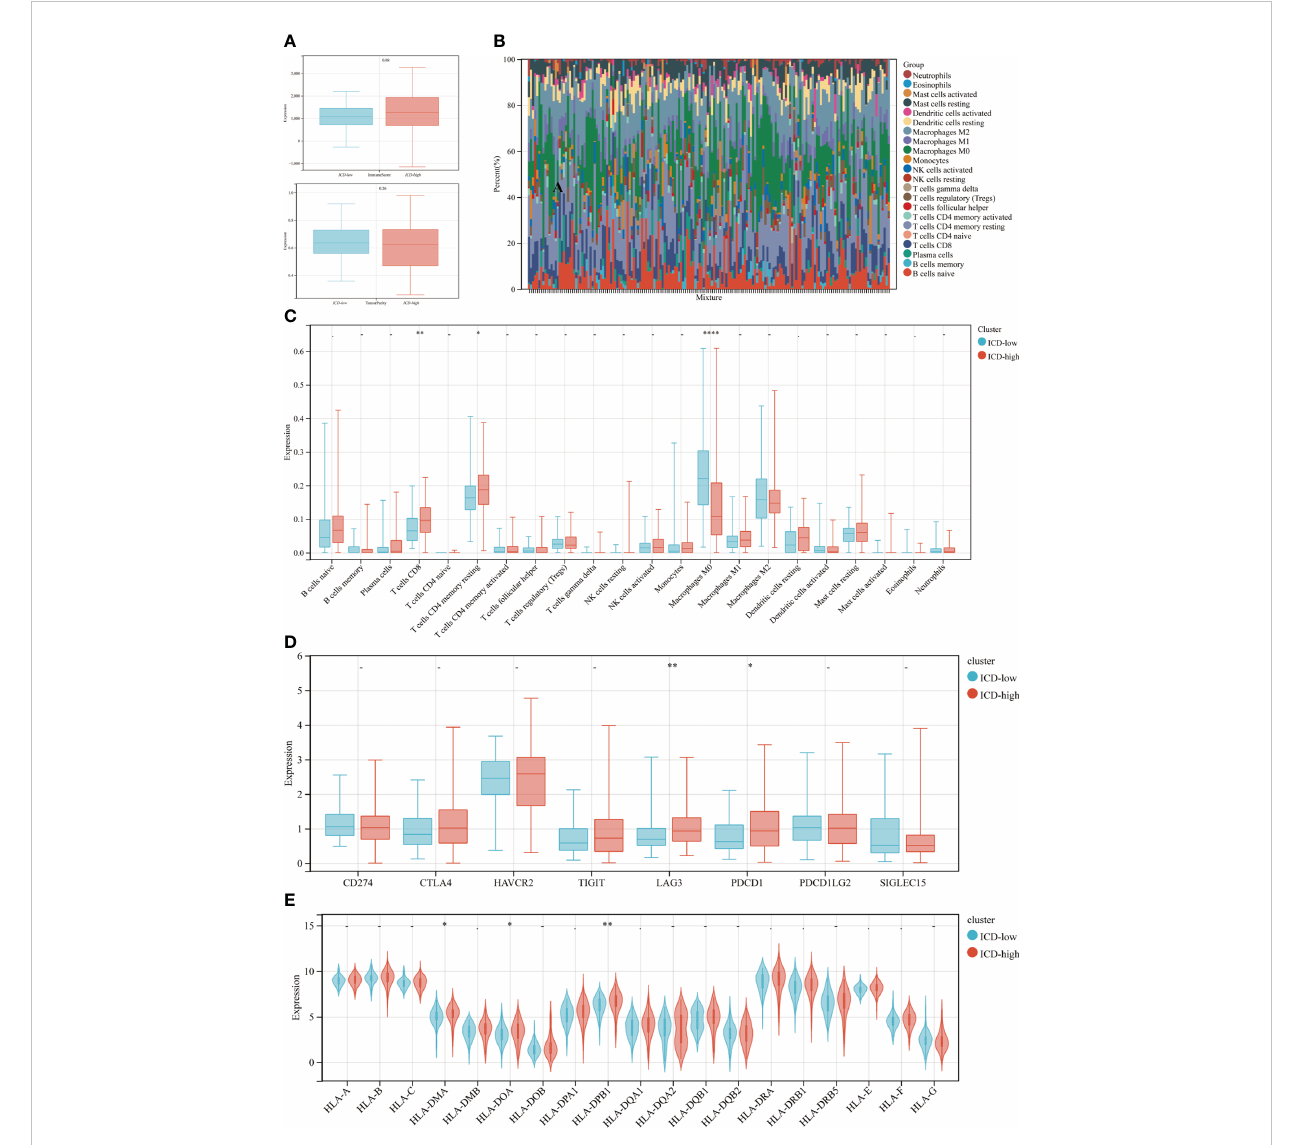
FIGURE 4 Immune landscape of ICD-low and ICD-high subtypes. (A) The median and quartile estimates for each immunological score and tumor purity score are shown in box plots. (B) Immune in fi ltration percentage in ICD-high and ICD-low subgroups; (C) The violin plot depicted considerably diverse immune cells across distinct subtypes. (D, E) Box and violin plots showed the expression of numerous immunological checkpoints (D) and HLA genes (E) differing between ICD-high and ICD-low subgroups. *P < 0.05, **P < 0.01, and ****P <